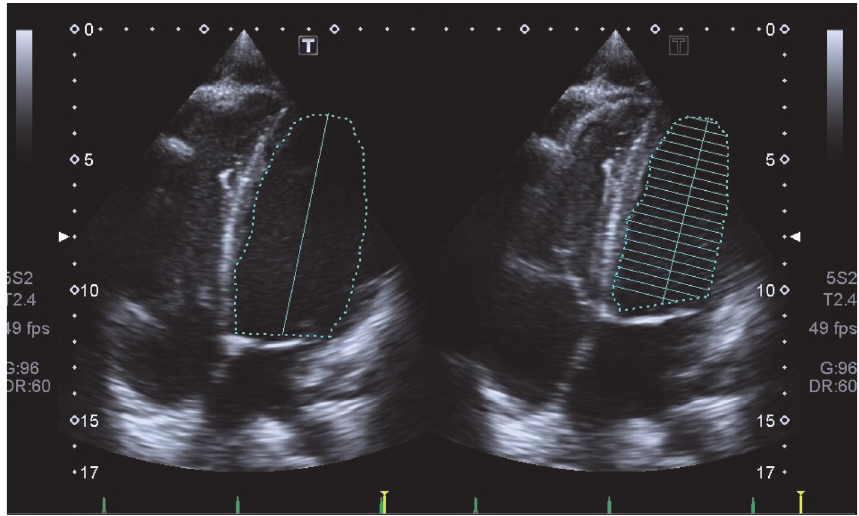
Figure 2: Apical view, apical position showing reduced apical wall motion of both ventricles (left ventricular ejection fraction 45%).